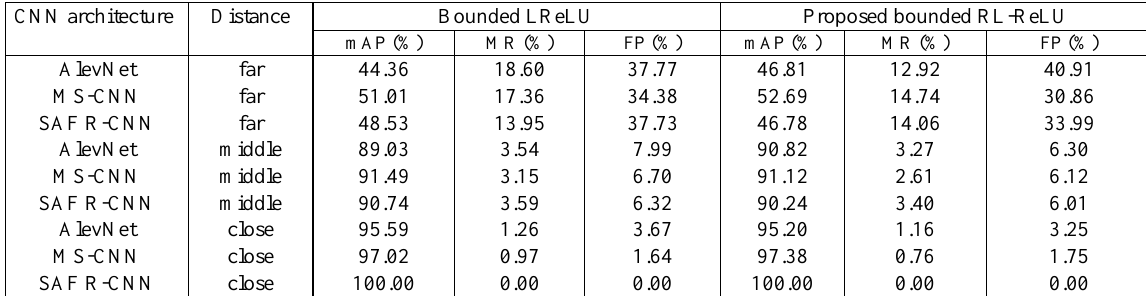
Table 4. Efficiency of CNNs with different types of ReLU activation functions